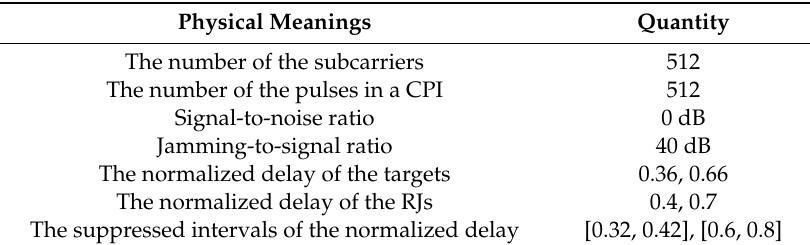
Table 2. Simulation Parameters for Suppressing RDJ.